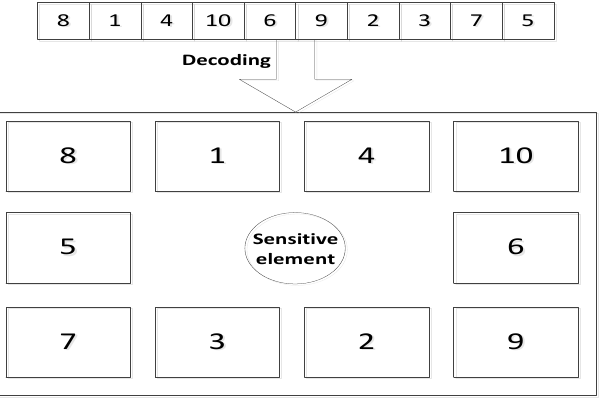
Figure 10. The optimal layout result and decoding of the 10 electronic